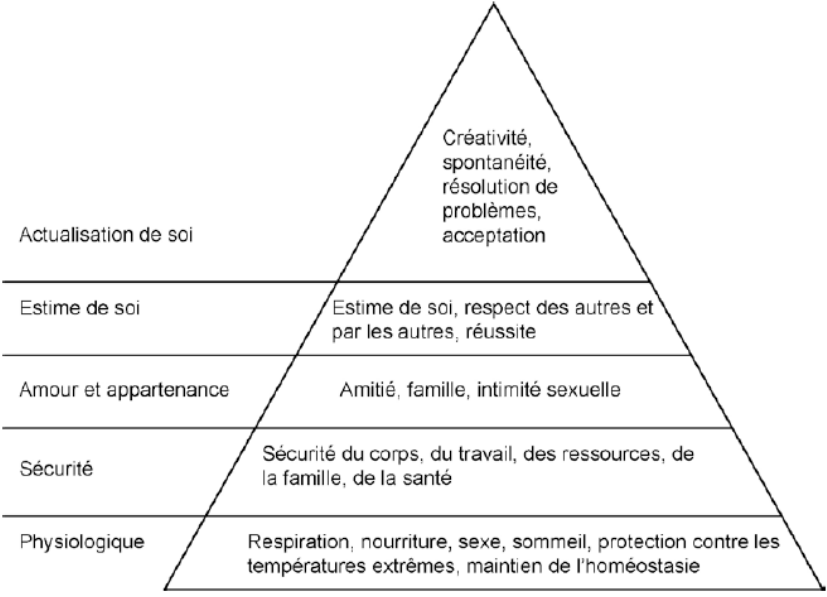
Figure 1 Schéma adapté de la